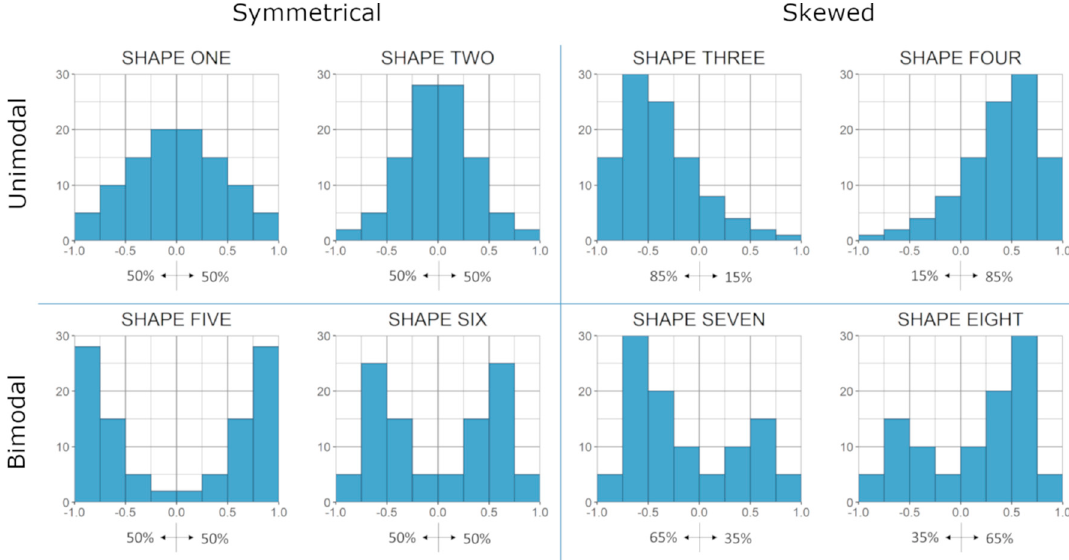
Figure 1. Distribution shapes template. Individual genes were assigned to one of these eight distributions shapes based on their correlation coefficients to all other expressed genes. Distributions were based on the proportion of correlations falling in each of the eight 0.25-bins of the − 1 to +1 range.